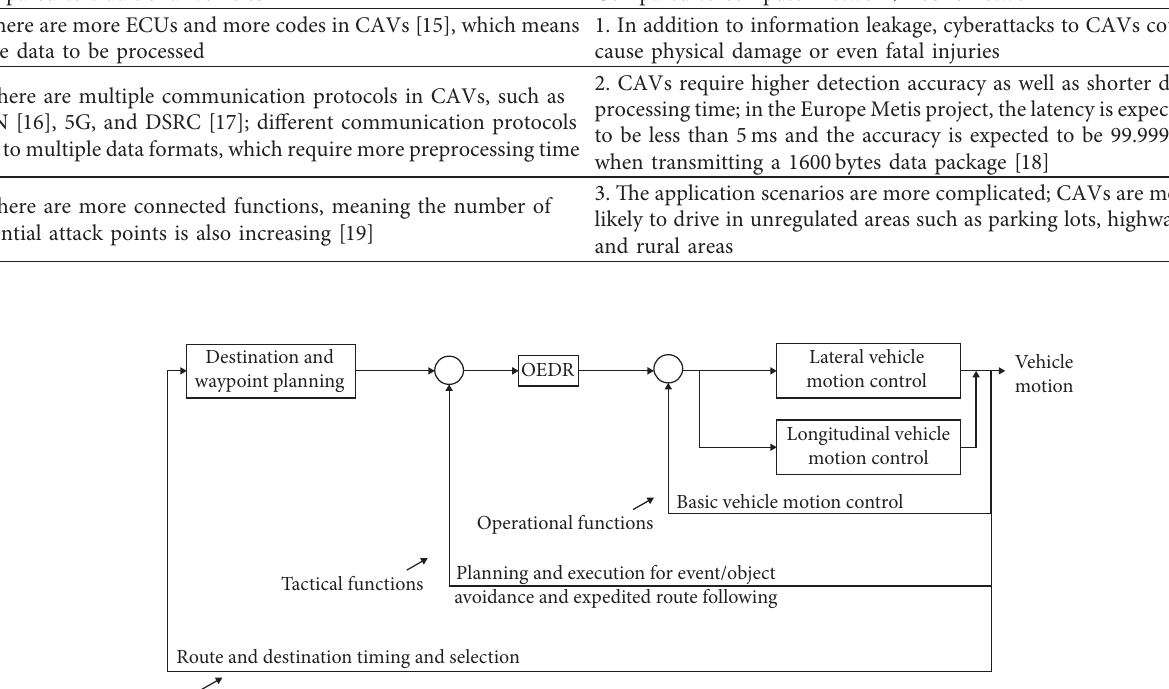
Table 1: Comparison of CAVs/traditional vehicles/mobile networks. Compared to traditional vehicles